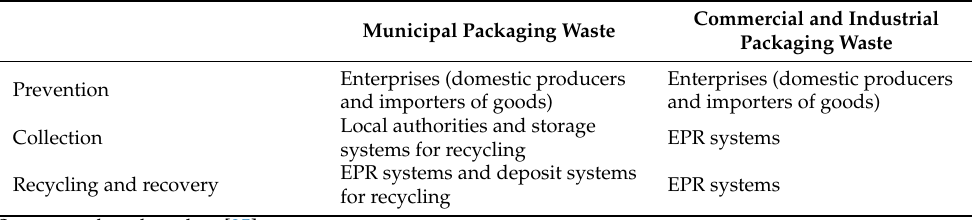
Table 4. Responsibilities for prevention, collection, recycling, and recovery in the Netherlands.